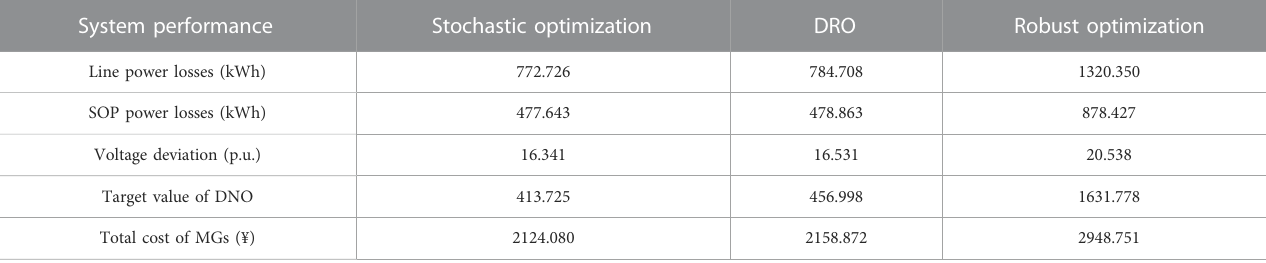
TABLE 8 Comparison of result between DRO and other methods. System performance